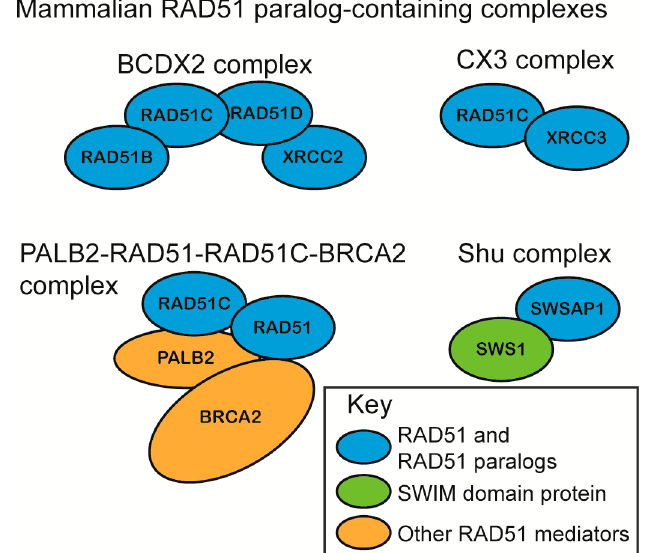
Figure 2. Mammalian RAD51 paralog-containing complexes. The BCDX2 complex is a RAD51 paralog heterotetramer consisting of RAD51B, RAD51C, RAD51D, and XRCC2. The CX3 complex is a RAD51 paralog heterodimer consisting of RAD51C and XRCC3. The PALB2–RAD51–RAD51C–BRCA2 complex consists of the RAD51 paralog, RAD51C, RAD51 itself, and two additional RAD51 mediator proteins, BRCA2 and PALB2. PALB2 acts as a scaffold in this complex by interacting with RAD51, RAD51C, and BRCA2. The Shu complex consists of a highly divergent RAD51 paralog, SWSAP1, and its binding partner SWS1. SWS1 is a member of the evolutionarily conserved Shu2/SWS1 family, which contains a SWIM domain, and interacts with RAD51 paralogs throughout eukaryotes. The SWIM domain is a zinc finger-like domain, CXC…X n …CXHXXA, where X is any amino acid. Blue circles indicate RAD51 or a RAD51 paralog, a green circle indicates a SWIM domain containing a Shu2/SWS1 protein family member, and an orange circle indicates an additional RAD51 mediator protein.